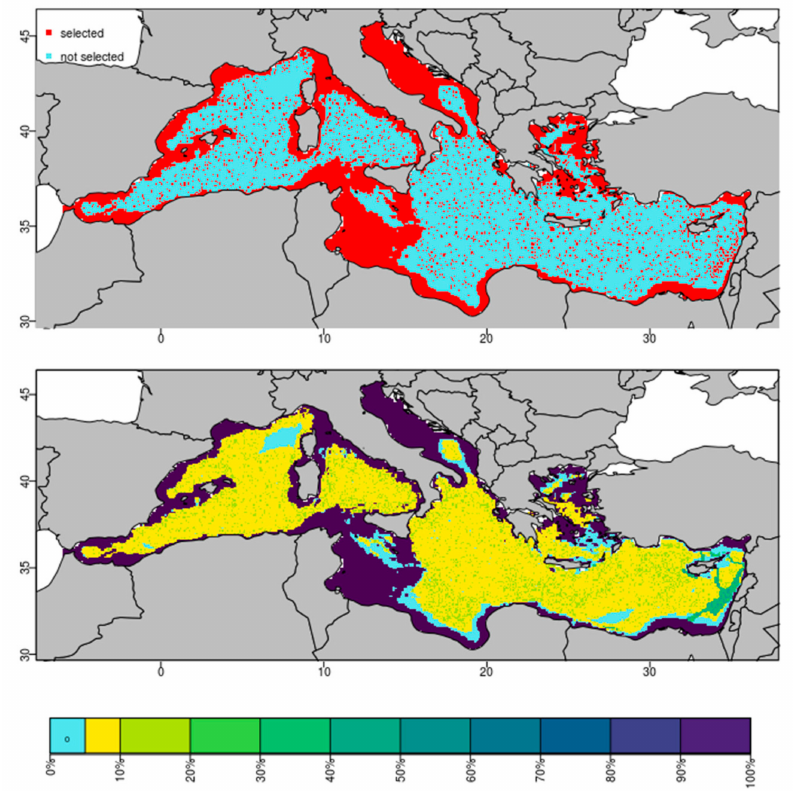
Figure A3. Conservation outcomes following the pre-selection approach. Top: optimal solution from exact optimization; Bottom: priority ranking values across sub-optimal